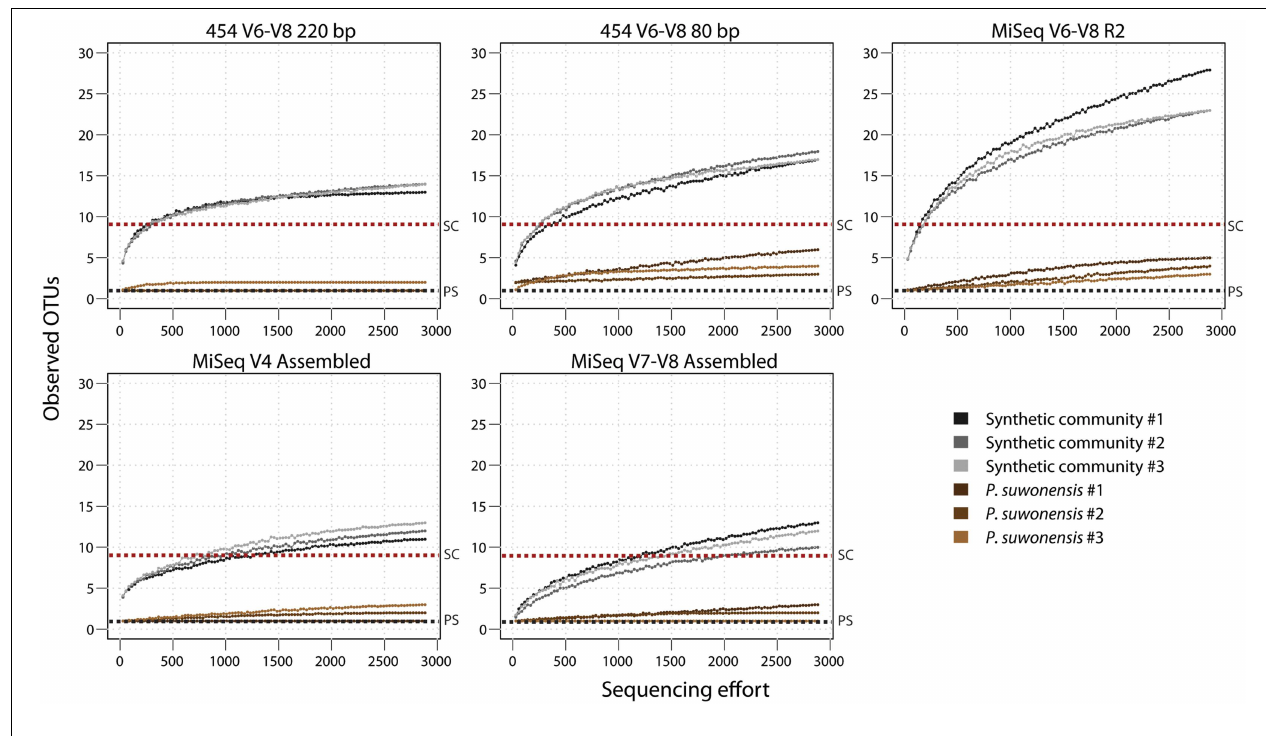
suwonensis (PS) and a red line for the synthetic community (SC). All OTU tables used to generate rarefaction curves were rarefied to 2893 reads per